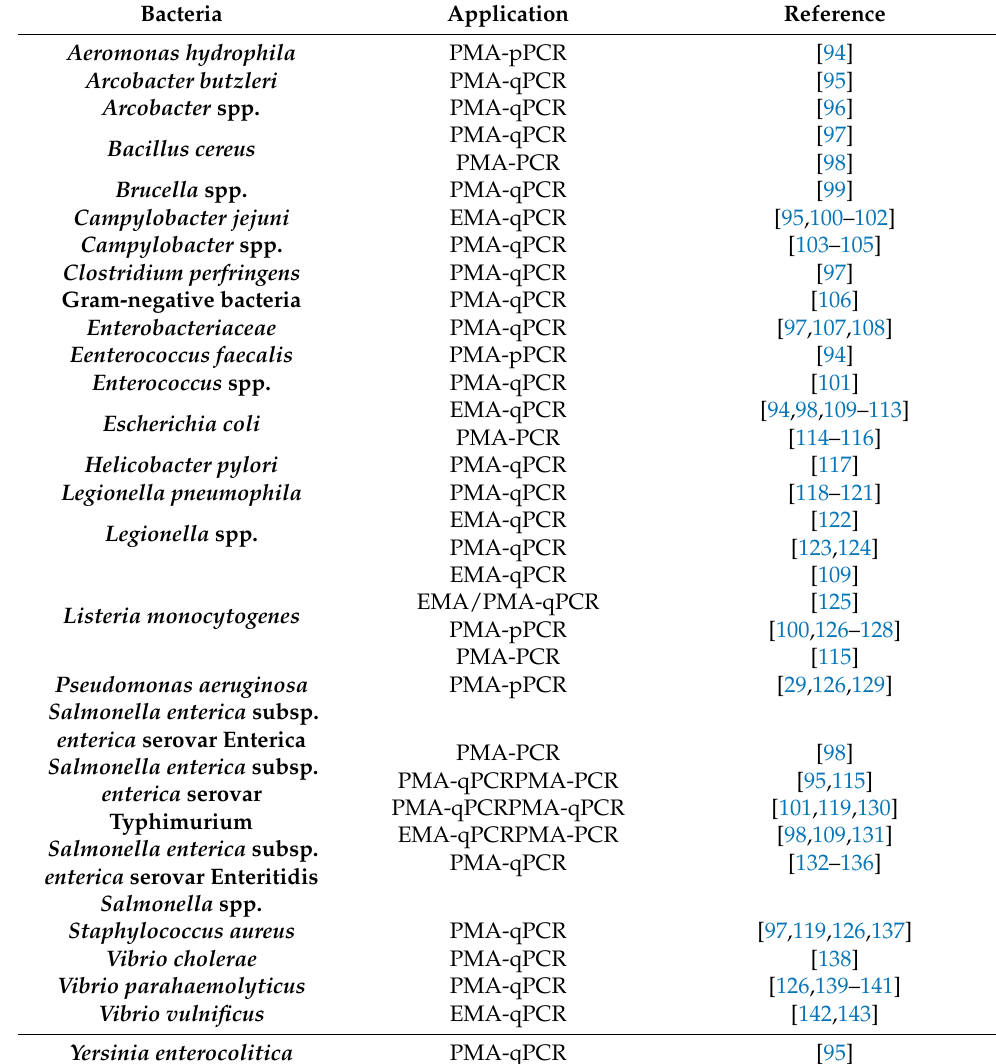
Table 1. PCR and qPCR propidium monoazide/ethidium monoazide (EMA/PMA)